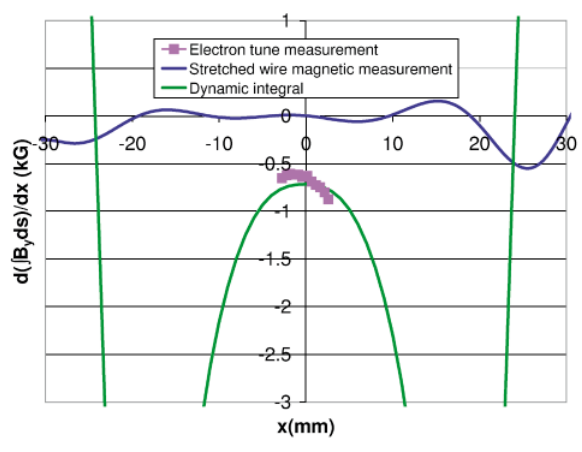
FIG. 5. (Color) Derivative of BL11 field integral for y (cid:1) 0 .